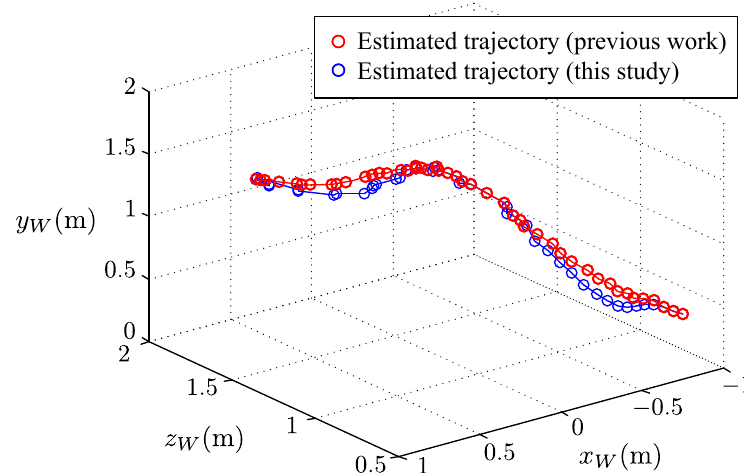
Figure 20. A flying ball: estimated trajectory of the ball.